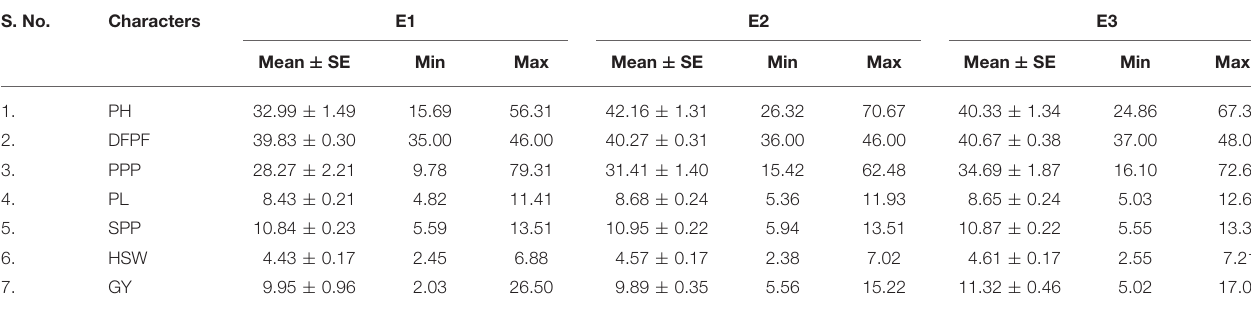
TABLE 2 | Mean and range of quantitative traits of mungbean in different environments. S. No.